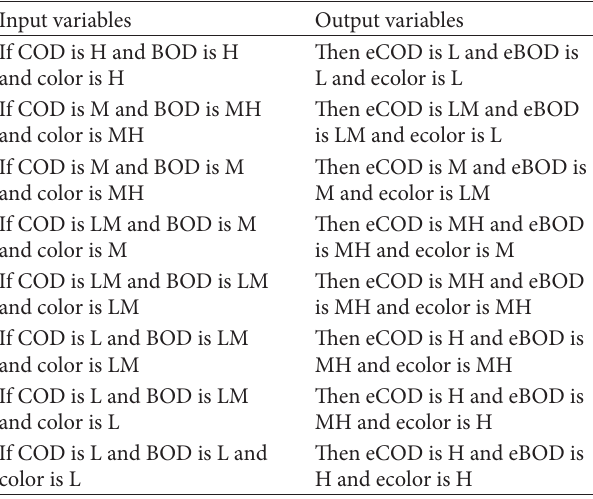
Figure 4: BOD removal efficiencies according to the different OLR values. Table 3: The rules used during fuzzy logic